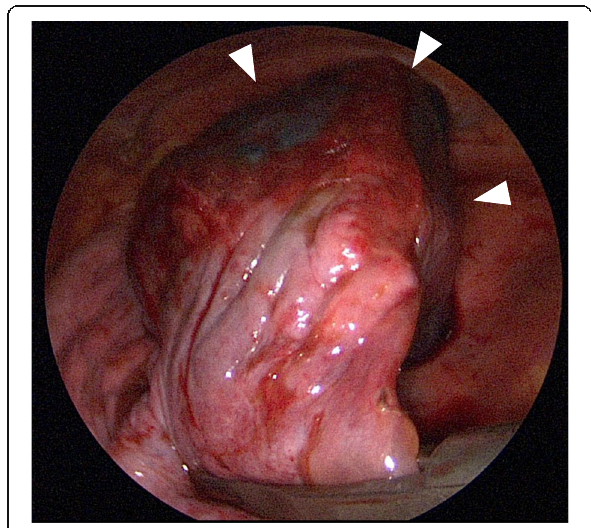
Fig. 3 A thoracoscopic view revealed a pulmonary cyst filled with a clot and bloody effusion